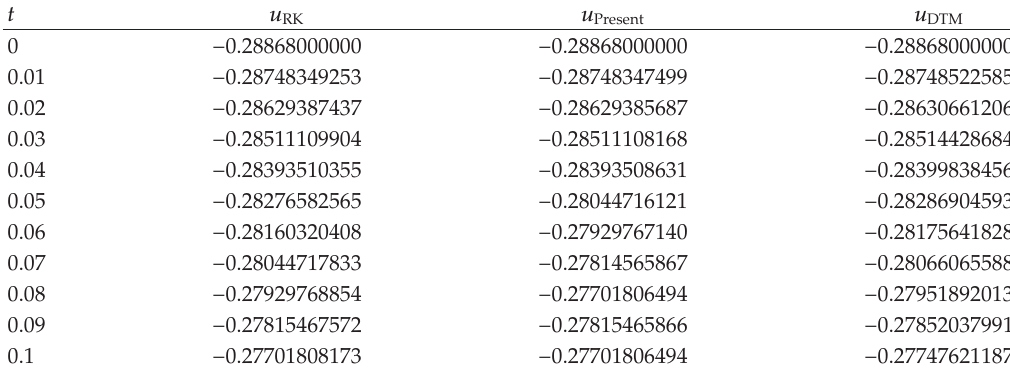
Table 1: Comparison between the RK4, DTM (cid:4) 16 (cid:5) , and present